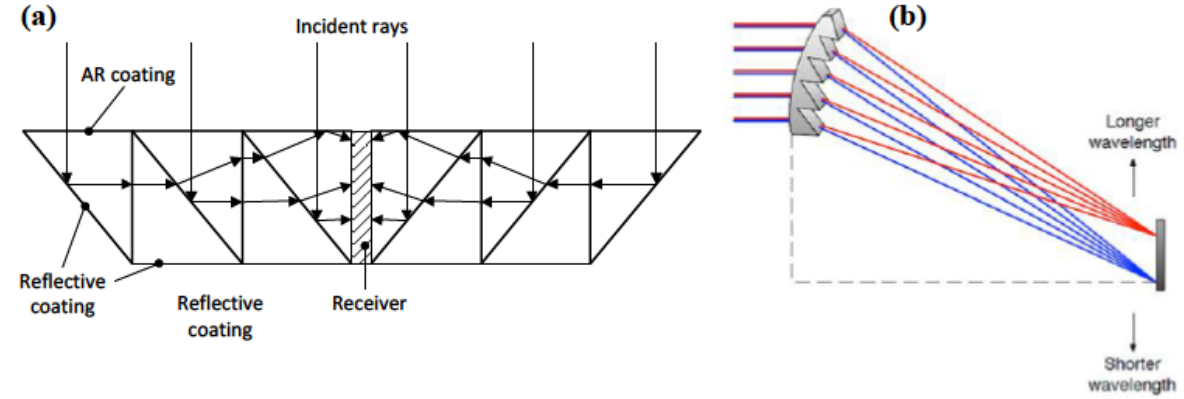
Figure 4: Refractive approach in light management [31]: (a) a refractive-waveguide concentrator. (b) A refractive concentrator/spectral sepa- rator [33].